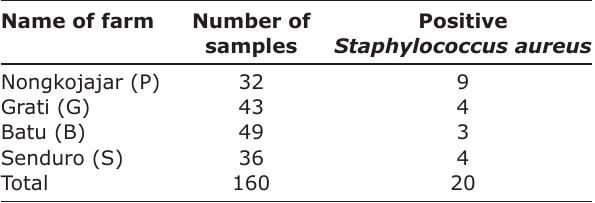
Table-1: Number of raw milk samples and Staphylococcus aureus from several dairy farms.